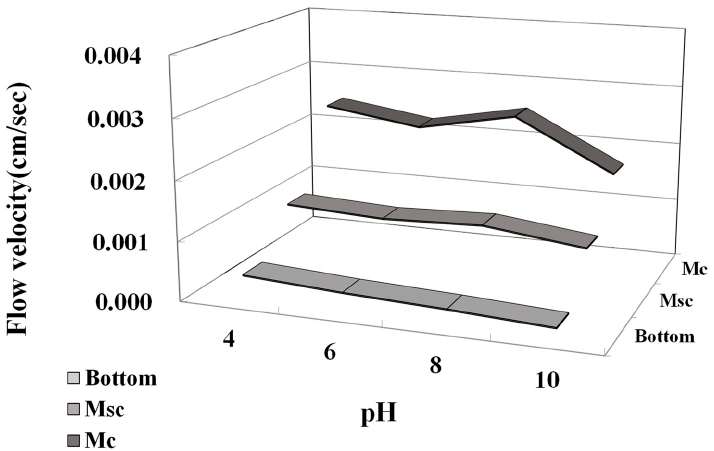
Figure 9. Microparticle flow velocity ( µ m/s).